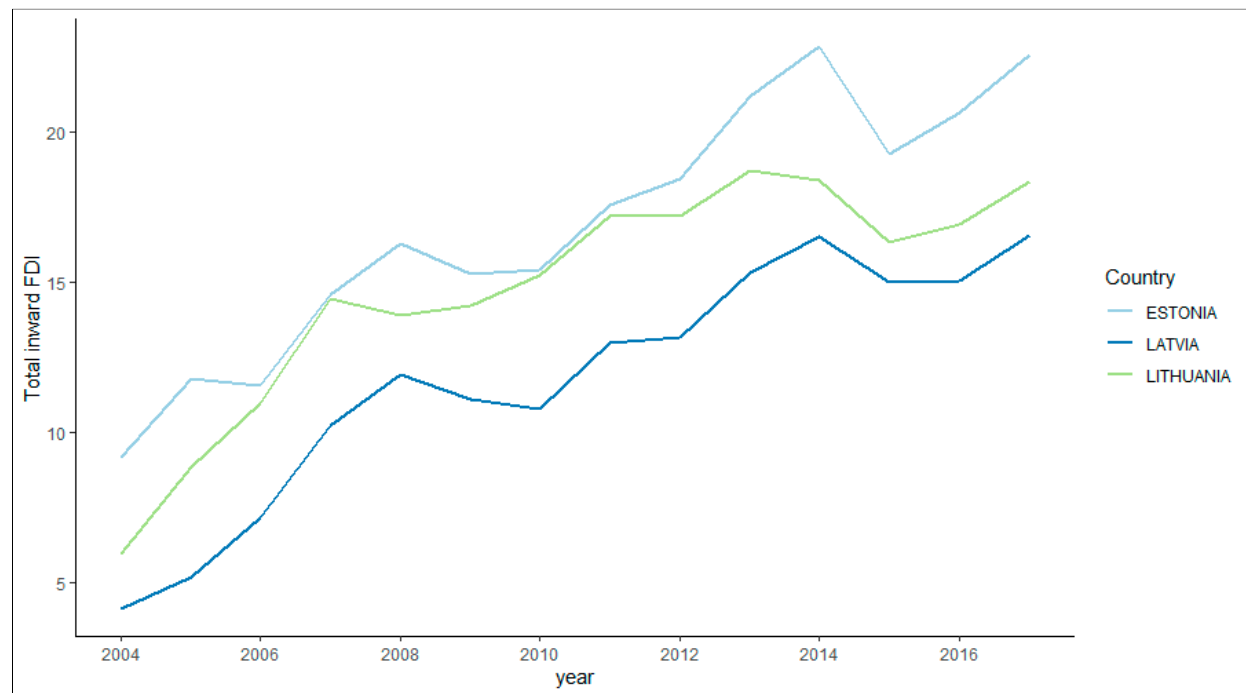
Figure A6. Average inward FDI stocks by partners in Lithuania across 2004–2017.